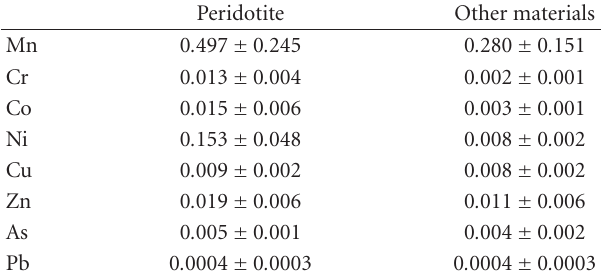
Table 2: Water-soluble heavy-metal concentrations (mgkg − 1 ) in sediments from peridotite and from other materials in the Verde River basin.